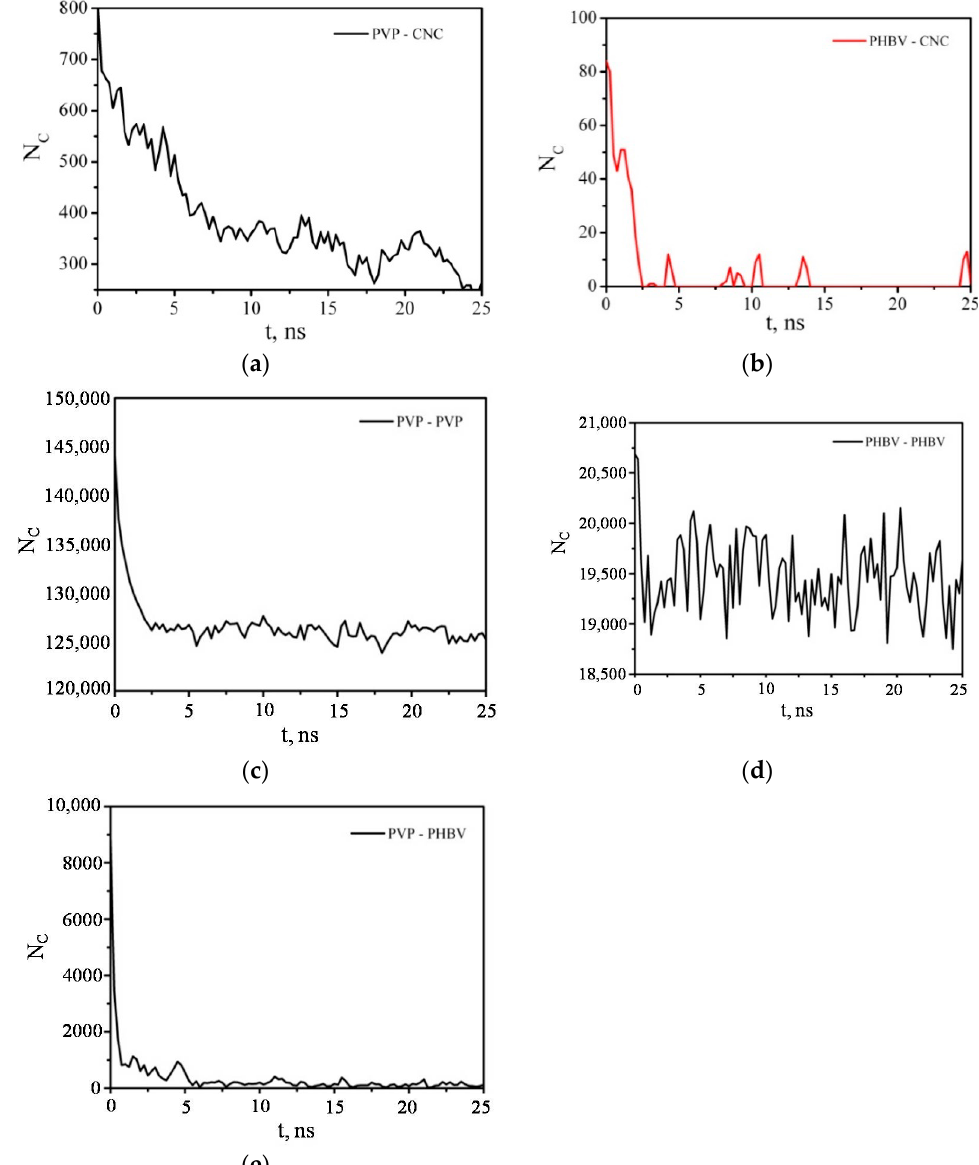
Figure 18. Time dependence of the number of contacts N c between any pair of PVP–CNC ( a ), PHBV–CNC ( b ), PVP–PVP ( c ), PHBV–PHBV ( d ), and PVP–PHBV ( e ) atoms within 0.5 nm.